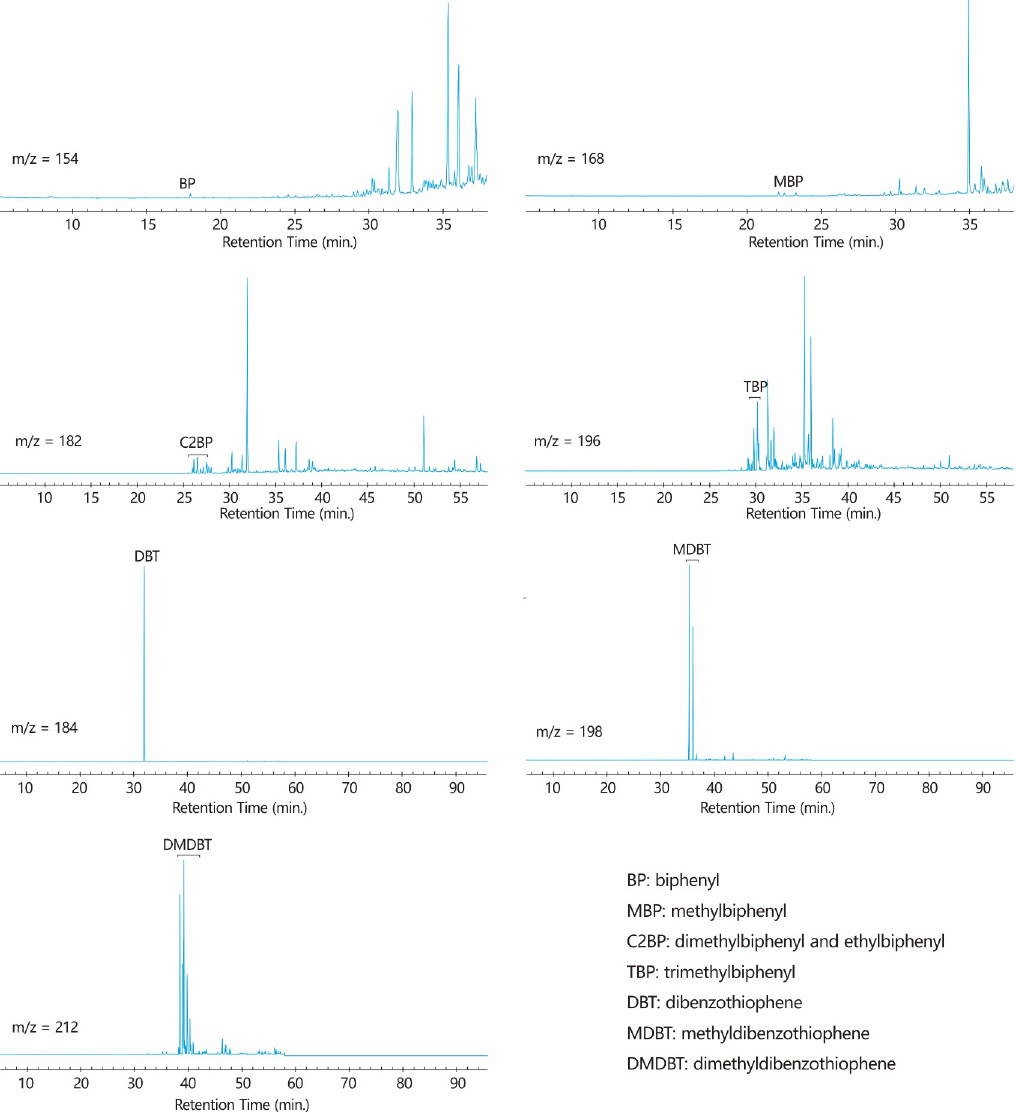
Figure 13. Mass chromatograms of the biphenyl series and dibenzothiophene series (QL-1).